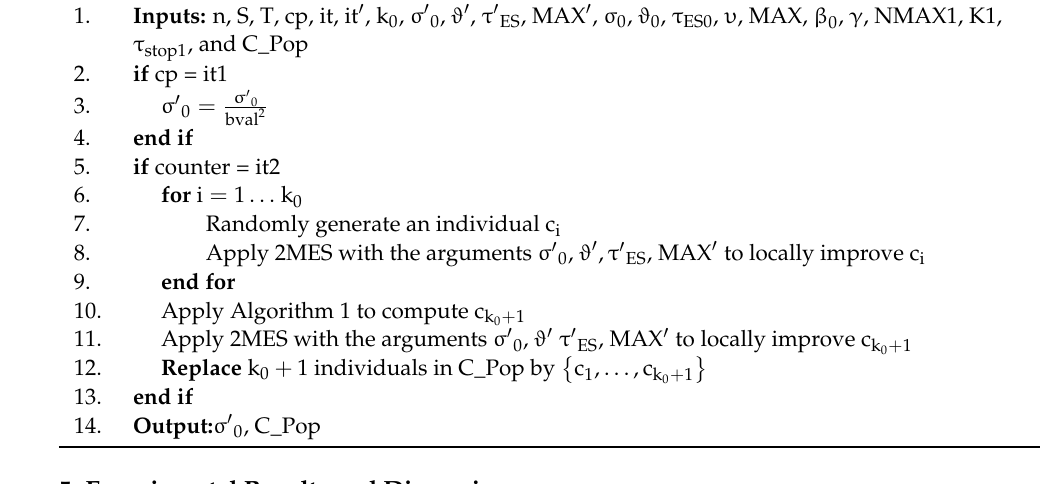
Algorithm 4 Premature Convergence Avoiding